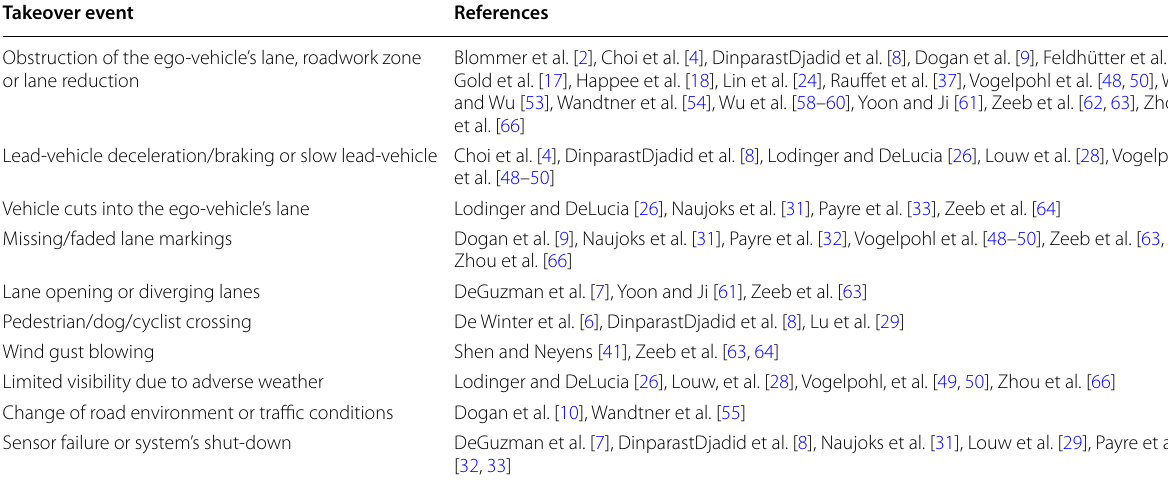
Table 2 Takeover scenarios identified in the selected studies Takeover